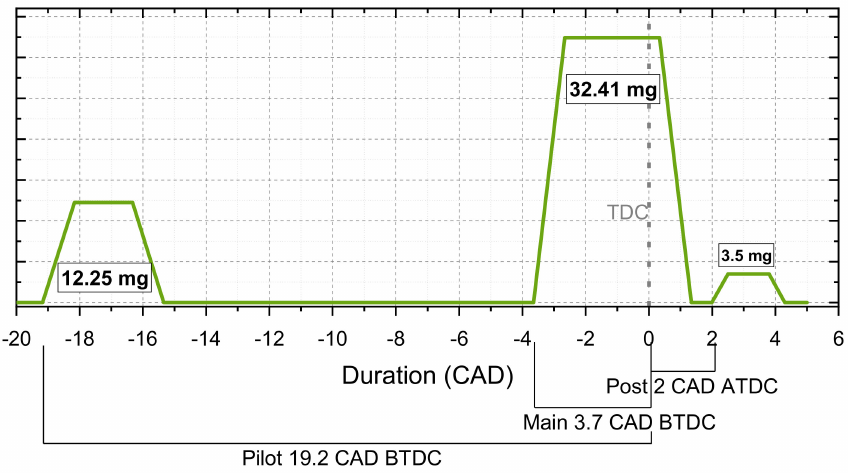
Figure 22. The fuel injection diagram at 25% load